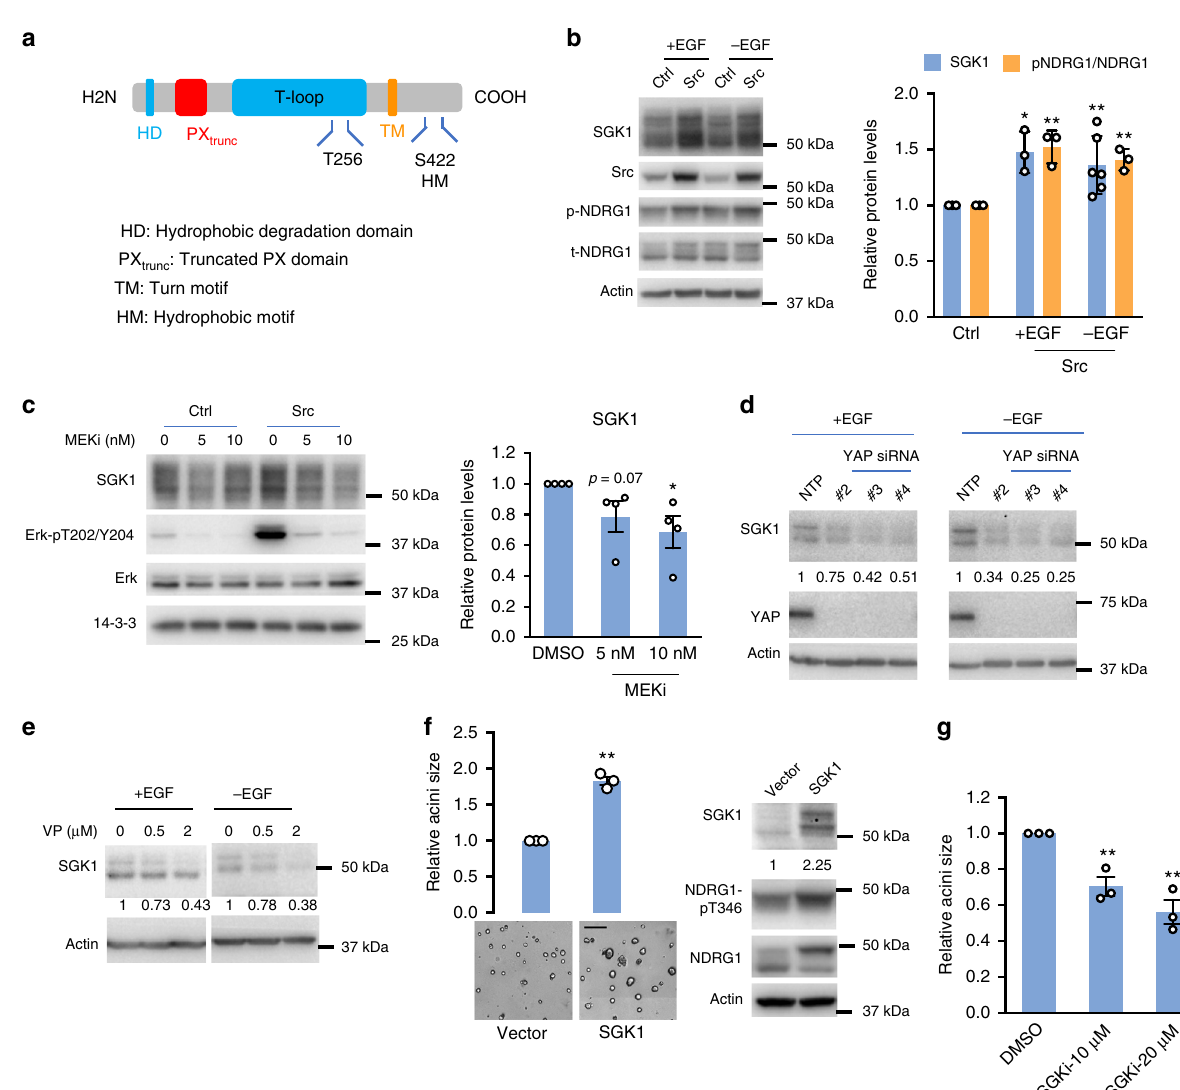
Fig. 5 SGK1 is required for Src-mediated transformation of MCF-10A cells. a Schematic representation of SGK1 protein structure. b Src Y527F expression increases SGK1 expression and activity. Lysates from MCF-10A_Ctrl (Ctrl) and MCF-10A_Src (Src) cells cultured in 2D culture − / + EGF were Western blotted as indicated. Representative blots are shown from between n = 3 and n = 6 biological replicates. c SGK1 upregulation by active Src requires MEK activity. Lysates from MCF-10A_Ctrl and MCF-10A_Src cells maintained in – EGF medium in 2D culture and treated with the MEK inhibitor, trametinib for 24 h were western blotted as indicated. DMSO was the vehicle control. Representative blots are shown from four biological replicates. d SGK1 upregulation is also YAP-dependent. Lysates from MCF-10A_Src cells cultured in 2D culture − / + EGF and transfected with three individual siRNAs for YAP or non- targeting control (NTP) (25 nM) were western blotted as indicated. e YAP inhibition reduces SGK1 expression levels. Lysates from MCF-10A_Src cells maintained as in ( d ) and treated for 16 h with the YAP inhibitor vertepor fi n (VP) (0.5 and 2 μ M) were western blotted as indicated. DMSO was the vehicle control. Representative blots are shown from n = 2 biological replicates. f SGK1 overexpression increases the size of MCF-10A_Src acini. Flag-SGK1 was overexpressed in MCF-10A_Src cells by retroviral infection and empty vector was used as control. Acini were grown under – EGF conditions and imaged and quanti fi ed from n = 3 biological replicates. Scale bar represents 200 μ m. The right-hand panel shows western blot analysis of cell lysates derived from the 3D cultures. g SGK1 inhibition reduces the size of MCF-10A_Src acini. MCF-10A_Src cells were treated with SGK1 inhibitor (SGKi) during acini growth under – EGF conditions. DMSO was the vehicle control. Acini were imaged and quanti fi ed from n = 3 biological replicates. b – g The column graph and numbers below the panels show the quanti fi cation of blots (normalized to actin or 14-3-3 which were loading controls) or acini with data expressed relative to the corresponding control which was arbitrarily set at 1. Error bars represent s.e.m., * p < 0.05, ** p < 0.01 by Student ’ s t